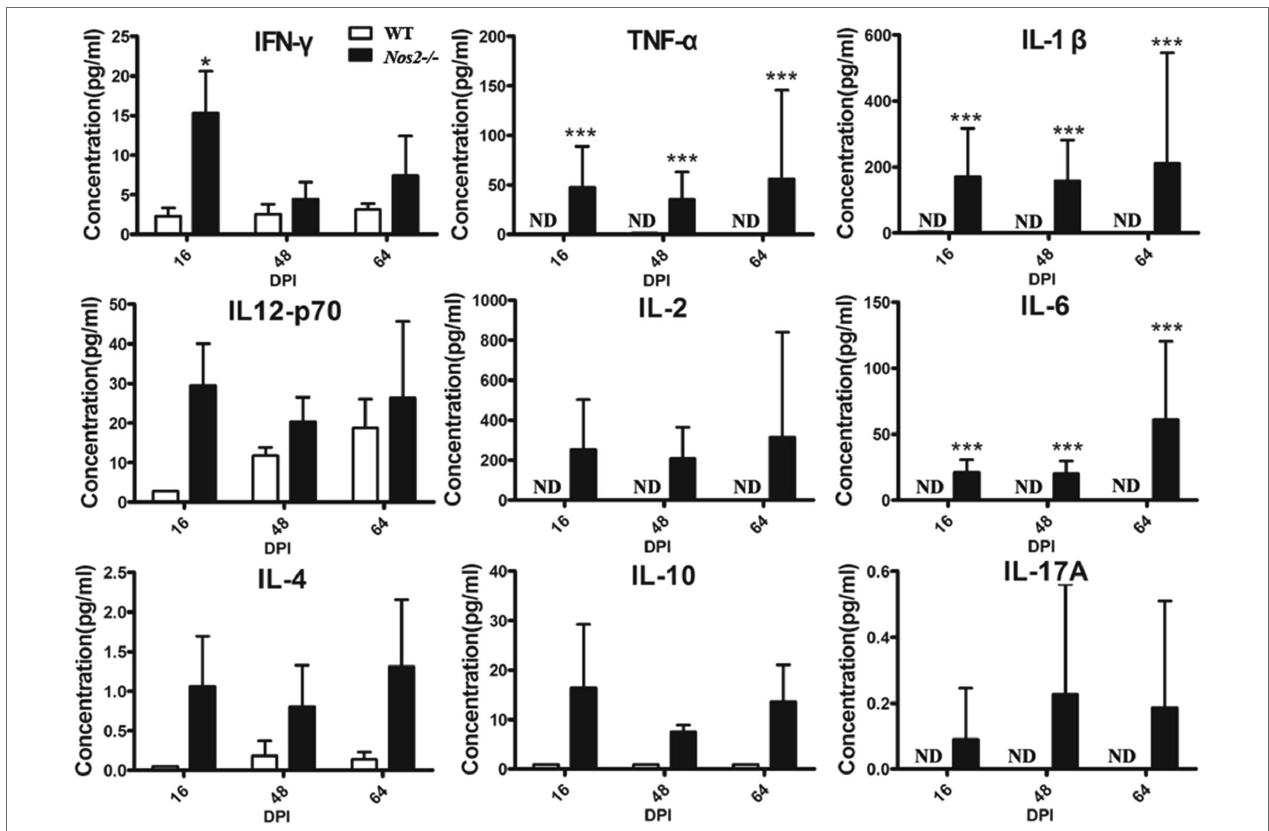
FIGURE 4 | Serum cytokine profiles of rats infected with Leishmania amazonensis . The serum of Nos2 − / − and wild-type rats were collected at 16, 48, and 64 days postinfection (DPI). Cytokine levels were determined by multiplex Luminex ( N = 3, mean ± SD). ND: not detectable. *indicates a significant difference (0.01 ﹤ P ﹤ 0.05);*** ( P ﹤